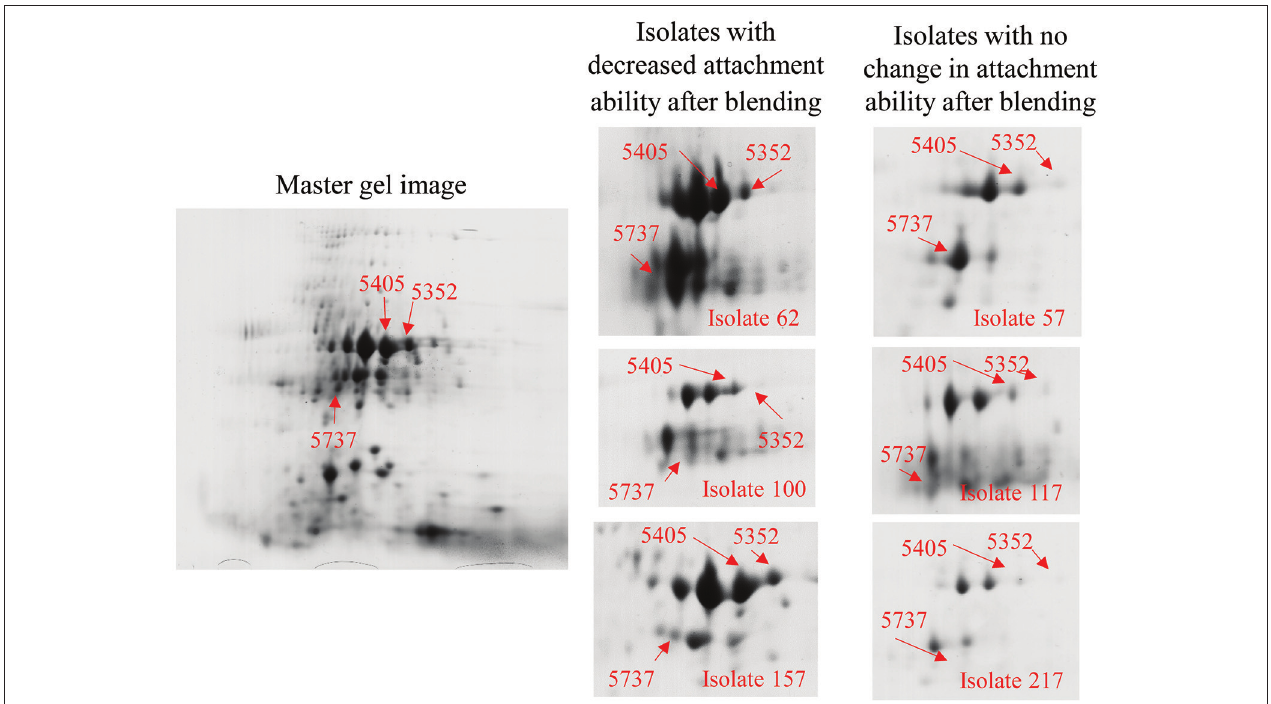
FIGURE 3 | Outer membrane proteomic analysis showed shifting of the OmpA-associated spot between groups of strains responding differently to blending. The photo on the left is a 2D gel selected as standard gel for SameSpots analysis. Spots were identified and selected for excision via the SameSpots software, but the images shown here are the raw images, manually labeled for clarity. The figures on the right show spots #5352, #5405, and #5737 ( Table 2 ) from each of the six strains. Excised spots were subjected to protein identification through in-gel digestion, MALDI-QUAD-TOF and MS/MS.